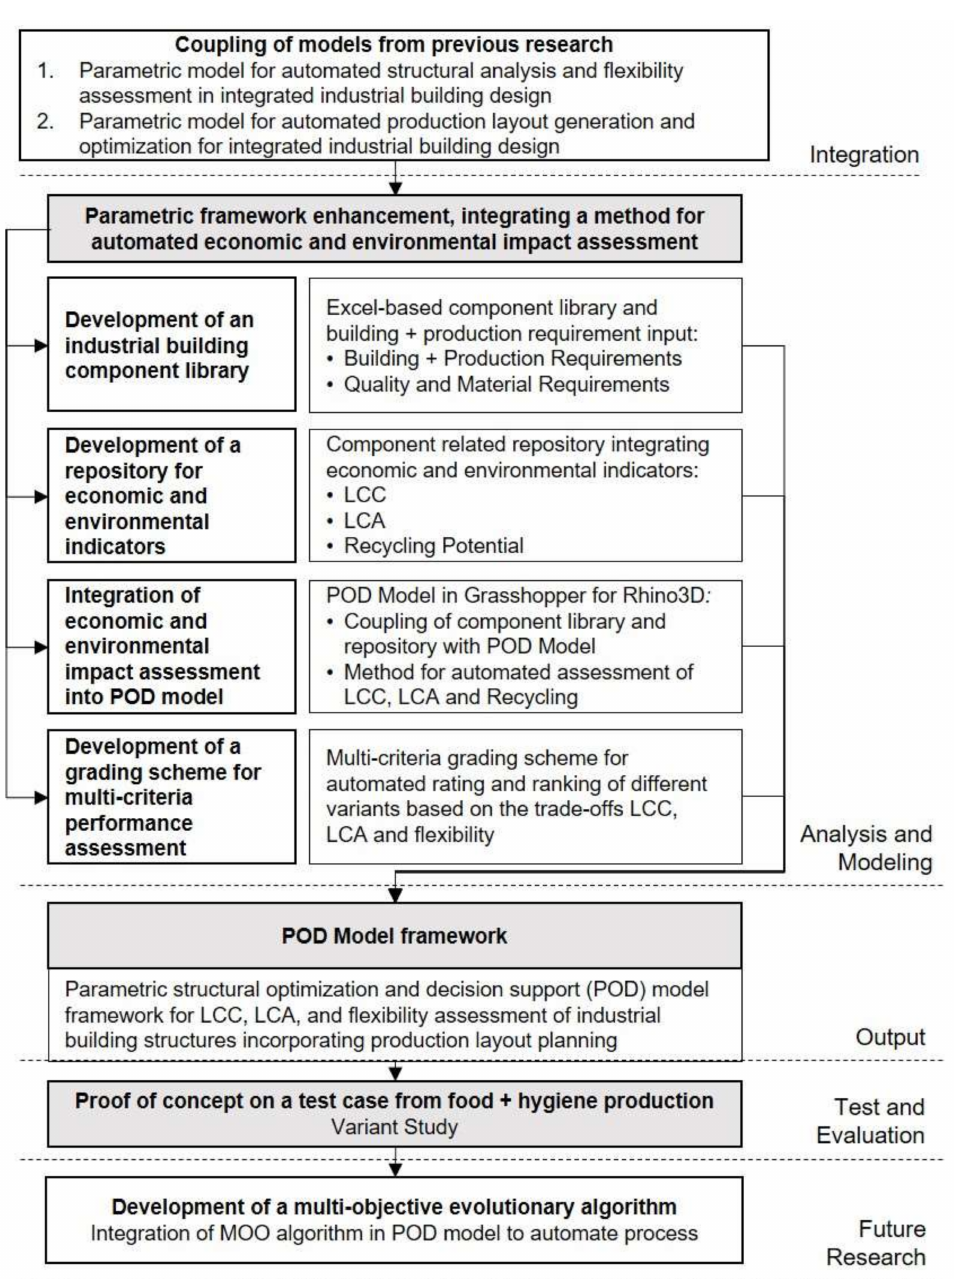
Figure 1. Overview of the research design and the scope of the